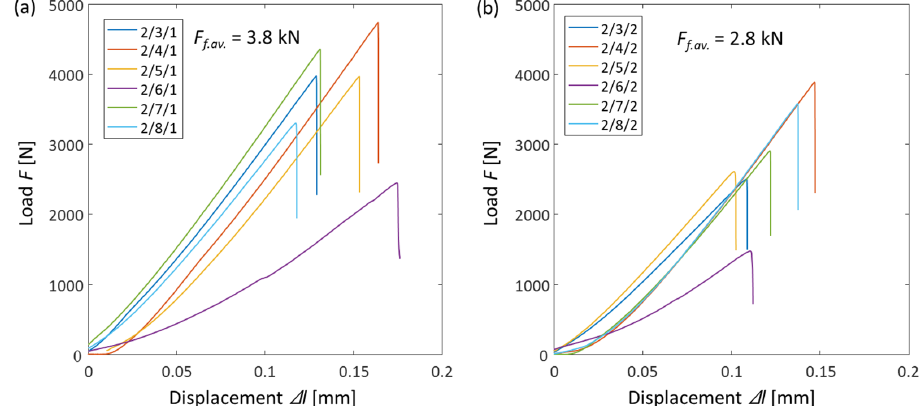
Figure 12. Diagrams of loading the geomaterial disk samples with indirect determination of the tensile strength: ( a ) air ‐ dried samples; ( b ) water ‐ wet samples. Knowing the load valued at the moment of fracture 𝐹 (cid:3033) , diameter 𝐷 and thickness 𝑡 of the sample, the tensile strength 𝜎 (cid:3003)(cid:3021)(cid:3020) can be calculated using the formula 𝜎 (cid:3003)(cid:3021)(cid:3020) (cid:3404) 0.636 (cid:3400) 𝐹 / 𝐷𝑡 in accordance with ISRM 0020 ‐ 7624 (Table 2). (cid:3033) Table 2. Results of the indirect tensile tests of limestone geomaterial samples. Data on air ‐ dried samples are in the top rows, and data on water ‐ wet samples are in the bottom rows. Load at Failure 𝑭 𝒇 , Diameter 𝑫 , Thickness 𝒕 , Sample mm mm